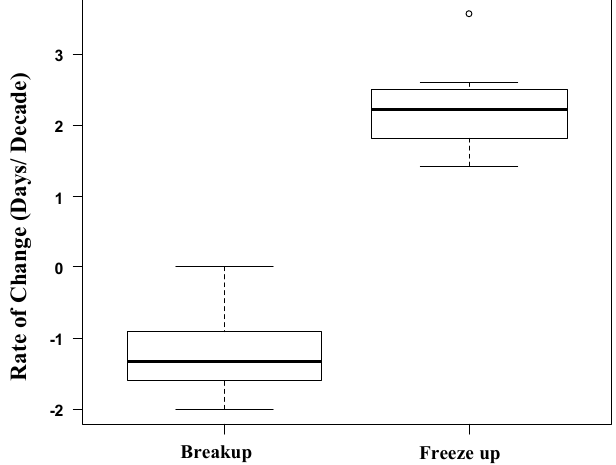
Figure 2. Rate of change of lake ice breakup and freeze up (day of year) in nine north temperate lakes between 1981/2 and 2014/5.